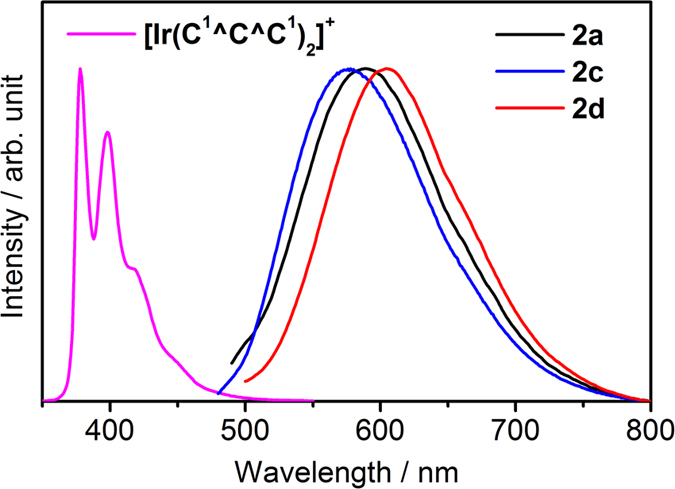
Emission spectra for 2a, 2c, 2d, and [Ir(C1^C^C1)2]+ (λex = 420 nm for 1–2, 340 nm for [Ir(C1^C^C1)2]+).